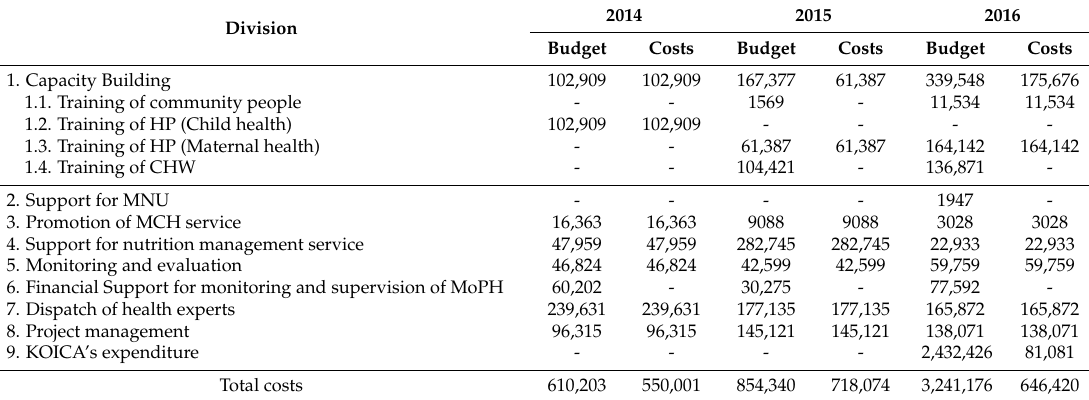
Table 1. Intervention costs of the maternal and child health (MCH) project in the Democratic Republic of Congo (DRC) by year (Unit: USD).